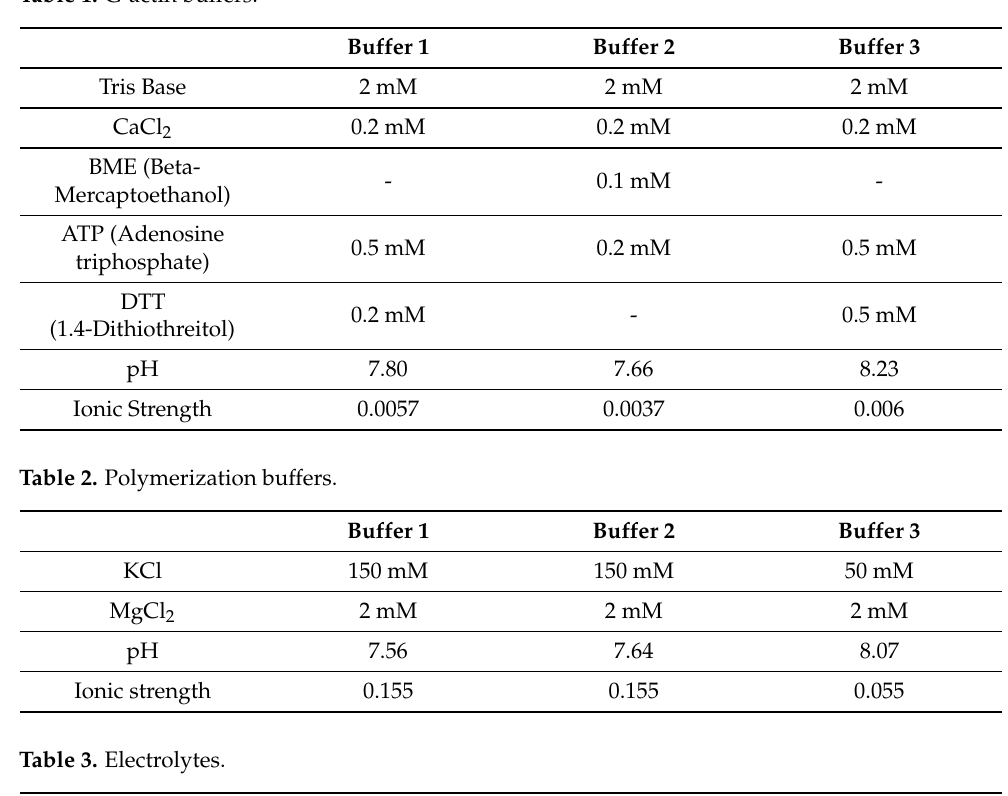
Table 1. G-actin buffers.